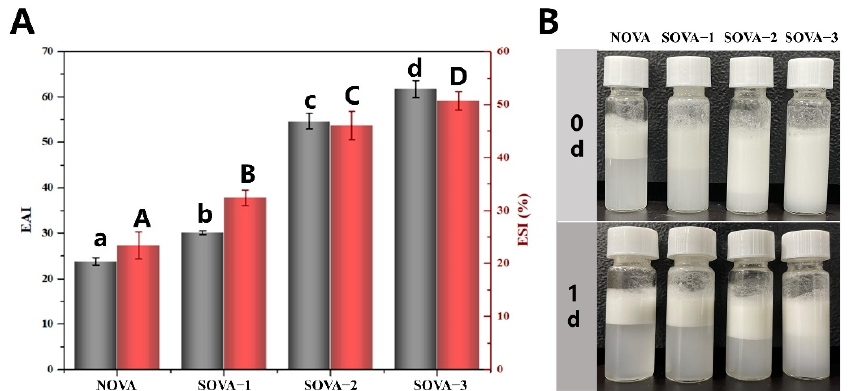
Figure 5. Emulsifying properties ( A ) and emulsion visual appearance stored for 0 d and 1 d ( B ) stabilized by OVA with different succinylated degrees. Different letters above the bars indicate a significant difference in the same indicator ( p < 0.05).